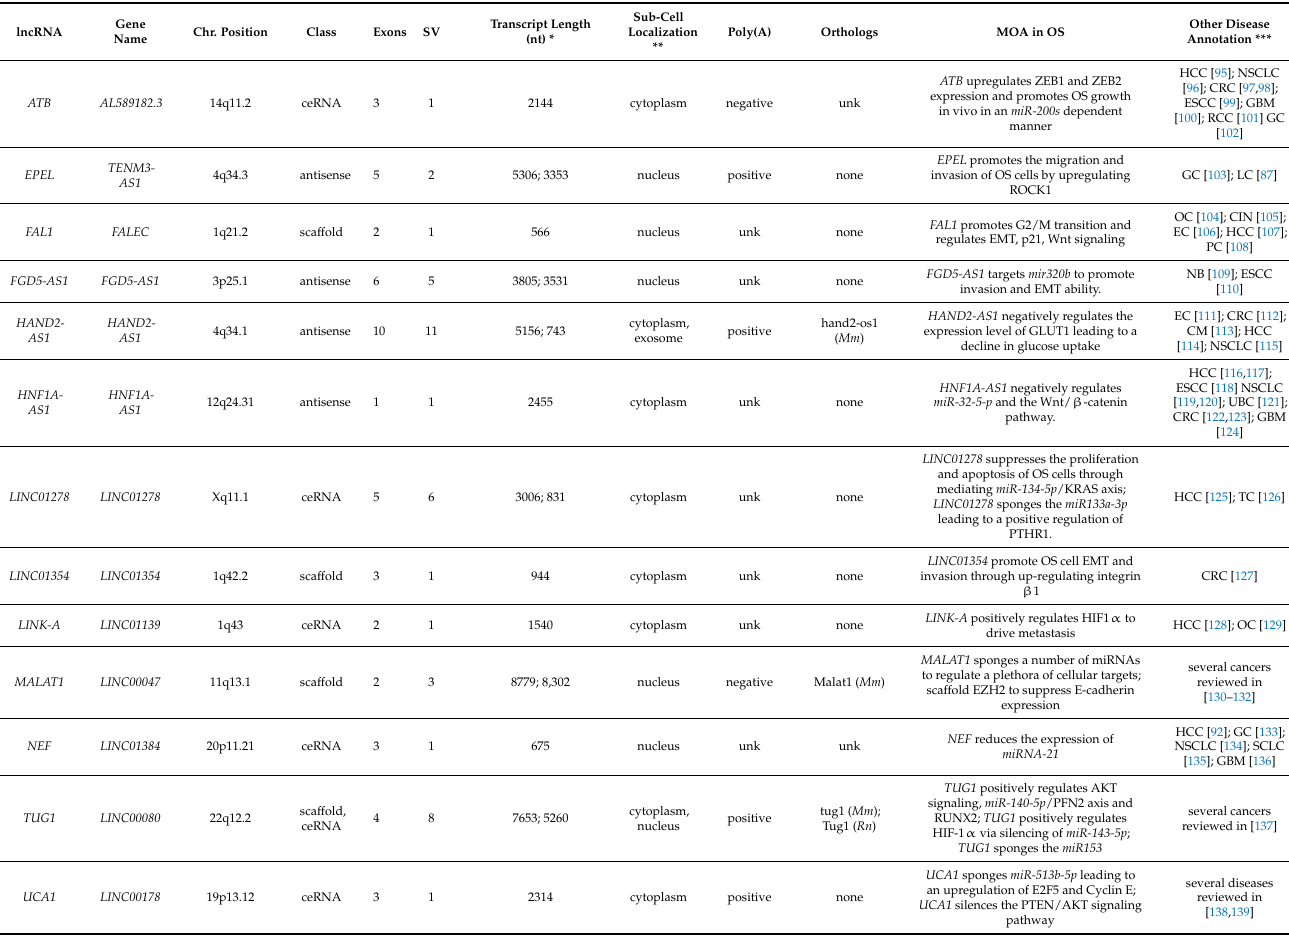
Table 2. Characteristics of the retrieved OS-associated circulating